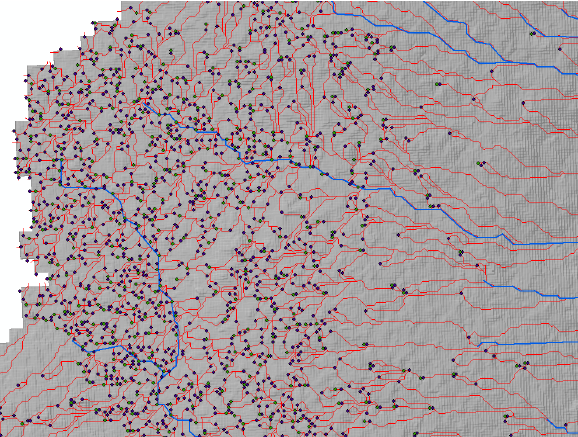
Figure 6: Pits (green) and saddles (blue) with thalwegs (red) and streams (blue) from box 2 of Figure 5 This approach is also more realistic for fluvially eroded terrains (Br¨andli, 1996) where there are few depressions. Point elevation Figure 5: DEM with drainage network (blue) superimposed on is not modified by this thalweg network (red)